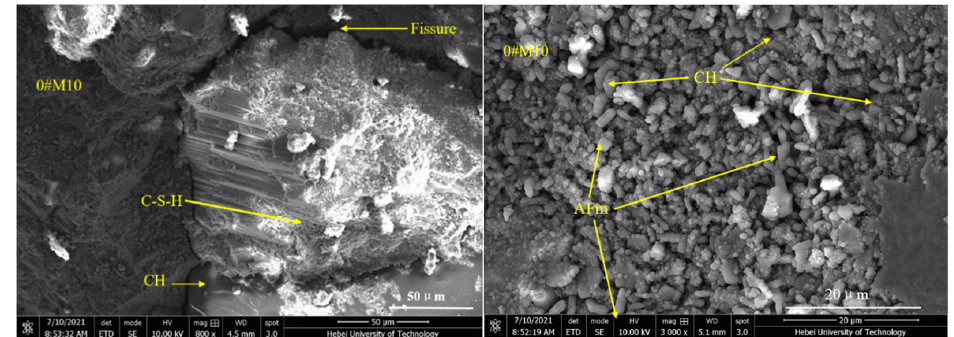
Figure 10. SEM images for 0#M10; ( a , b ) are SEM images of 0#M10.